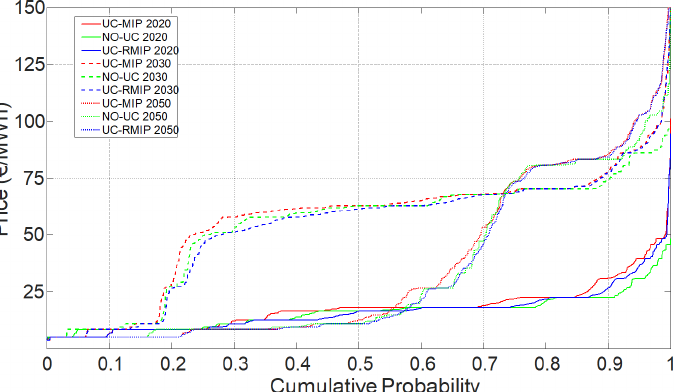
Figure 8. Probability distribution function of the hourly electricity price in DK1(one of the modelled regions of Denmark), for each year and UC modelling approach.